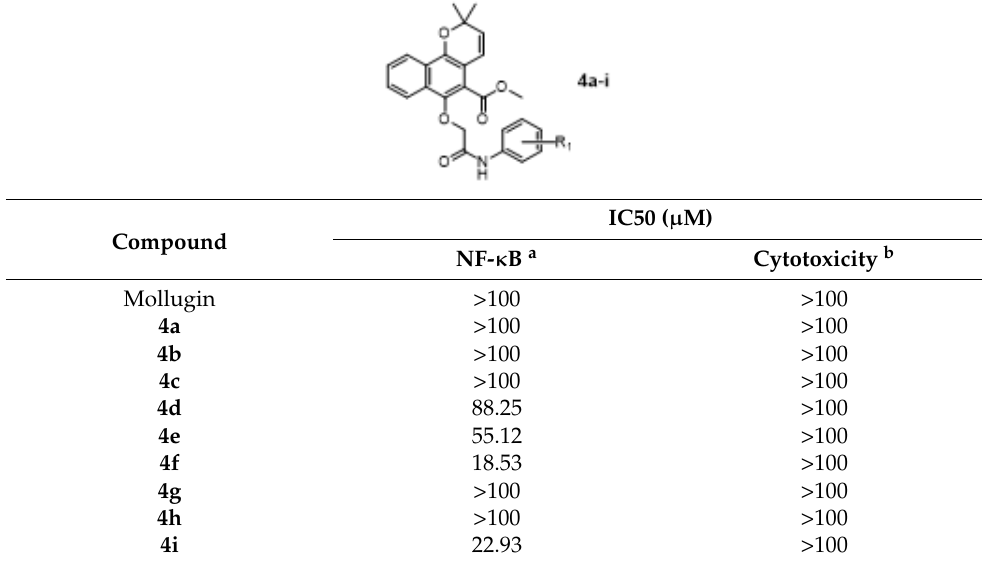
i. Table 1. In vitro inhibition of NF- κ B transcriptional activity and cytotoxicity of the compounds 4a–i .